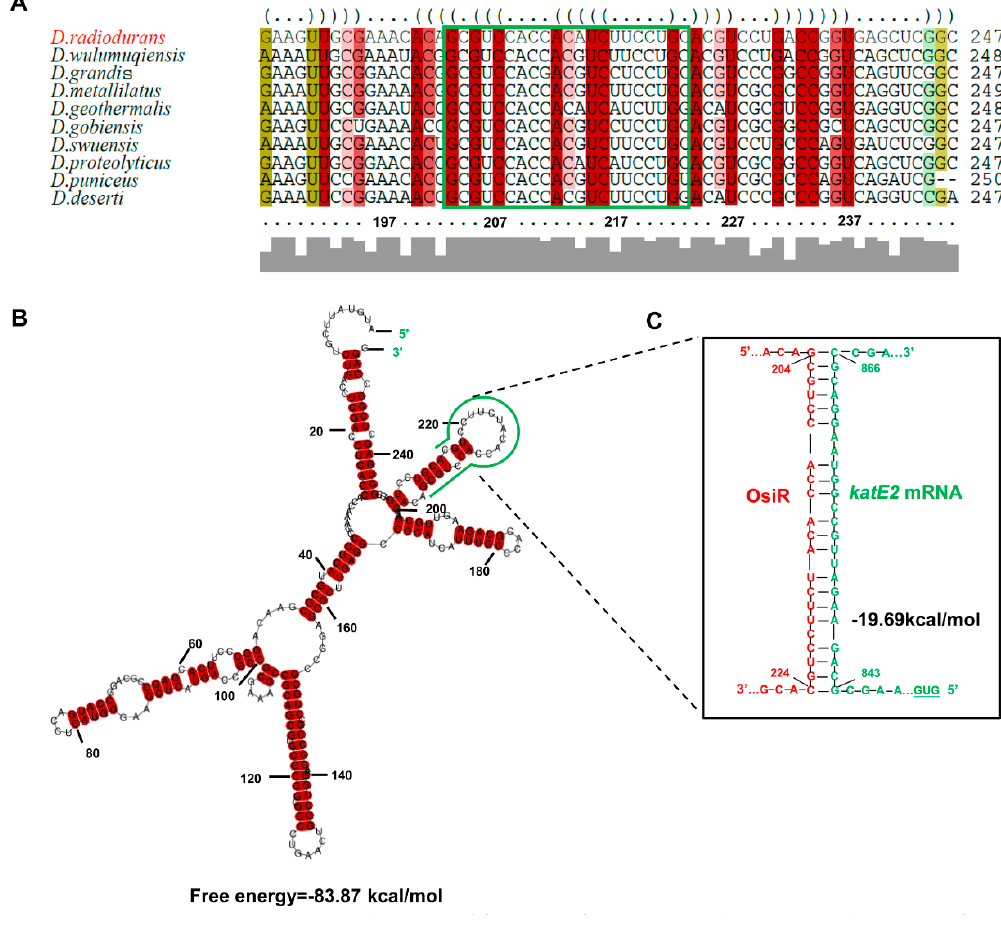
Figure 2. Sequence conservation and structural features of OsiR. ( A ) multisequence alignment of osiR homologous genes analyzed by LocARNA [39]. The colors indicate that the structural conservation, compatible base pairs are colored; the saturation decreases with the number of incompatible base pairs. Thus, it indicates the structural conservation of the base pair, for which red indicates 100% of the structure sequences is identical. ( B ) The secondary structure of OsiR predicted by RNAalifold [40]. The potential interaction region of OsiR with katE2 mRNA is shown in green. The secondary structure stability of ncRNA is represented by the free energy values. ( C ) The interaction between OsiR and katE2 mRNA analyzed by IntaRNA. OsiR is shown in red, and the katE2 mRNA is shown in green.